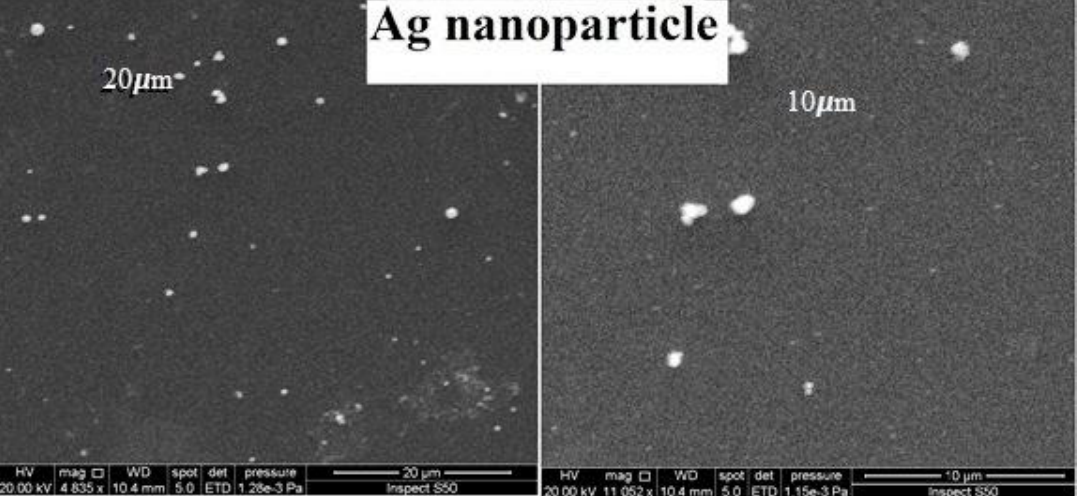
Fig. 5: SEM images for Ag nanoparticle deposited on glass substrate for 10 𝞵 m and 20 𝞵 m